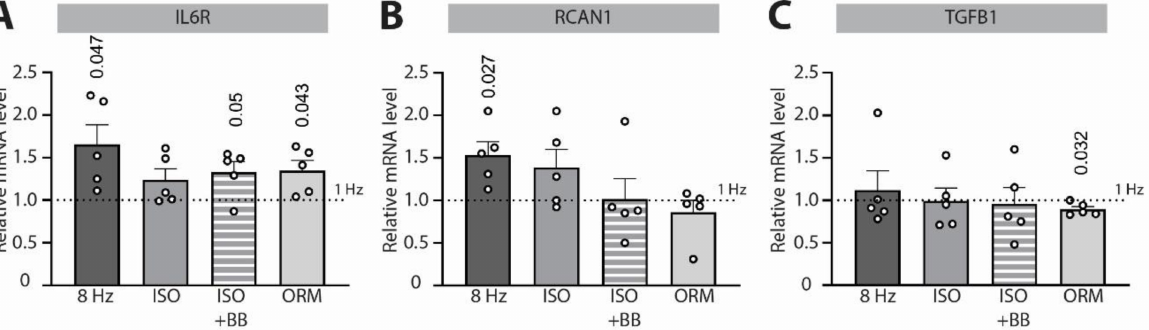
Figure 3. Effects of tachycardic pacing and β -adrenergic stimulation/inhibition on the expres- sion of hypertrophy- and cardiac-remodeling-relevant genes in neonatal rat ventricular cardiomy- ocytes (NRVCMs) . Relative expression of ( A ) interleukin-6 receptor ( IL6R ), ( B ) regulator of calcineurin 1 ( RCAN1 ) and ( C ) transforming growth factor β 1 ( TGFB1 ) exposed to 3 h of tachycardia (8 Hz) under control conditions or combined with β -adrenergic stimulation with isoprenaline (ISO), β -adrenergic stimulation following 1 h preincubation with β -blocker propranolol (ISO + BB) or treatment with NCX inhibitor ORM-10962 (ORM). All 8 Hz conditions were normalized to the respective low pacing frequency (1 Hz) condition (using the 2 − ∆∆ Ct method). Data are shown as mean ± SEM ( N = 5 isolations). Indicated p -values were calculated using a one-sample t